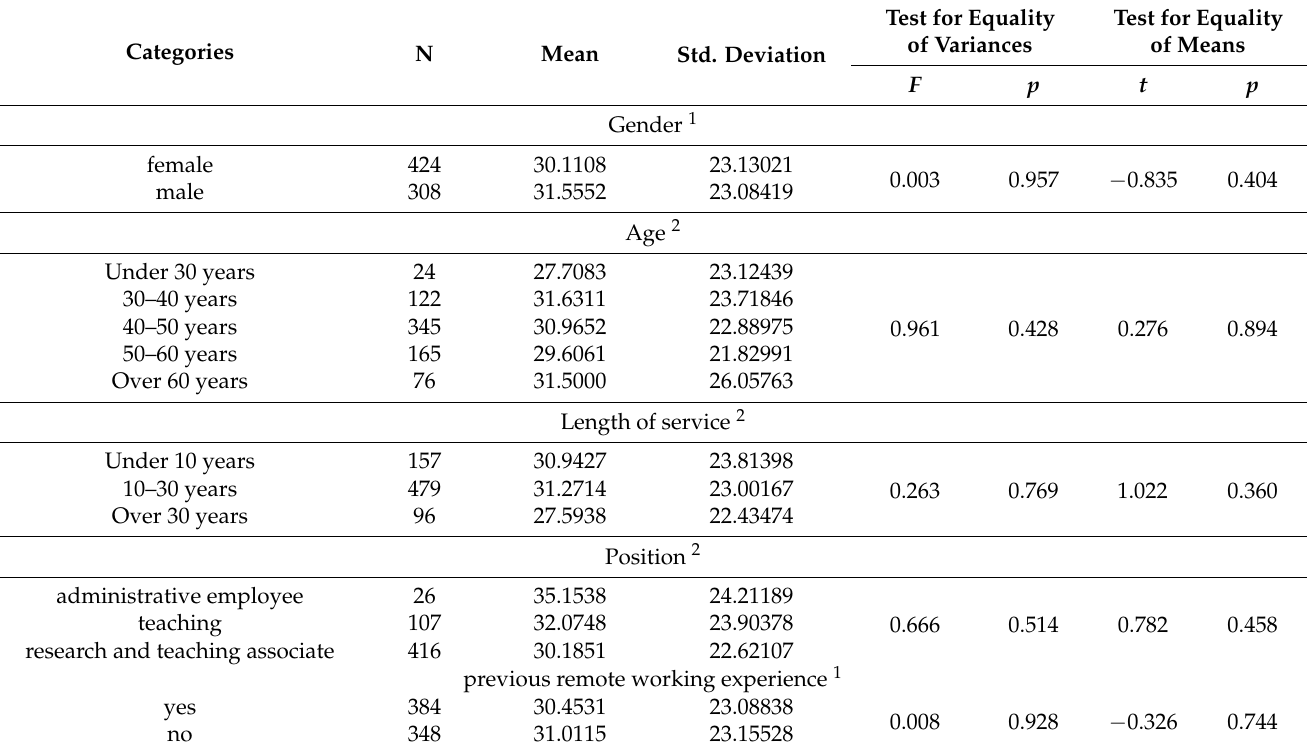
Table 2. Test for